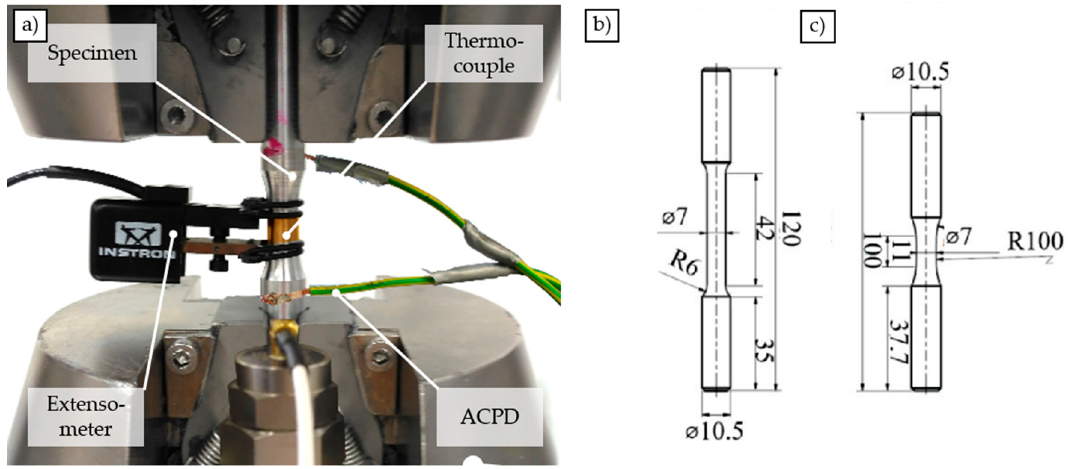
Figure 2. Experimental setup for fatigue experiments ( a ), specimen geometry for quasistatic ( b ), and fatigue ( c ) tests, all units in mm.